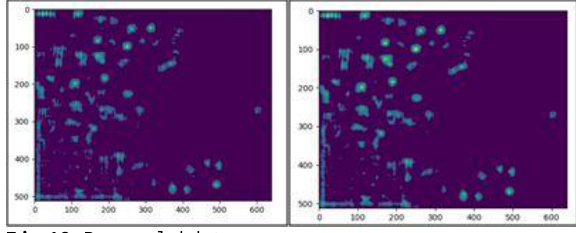
Fig. 12: Resampled